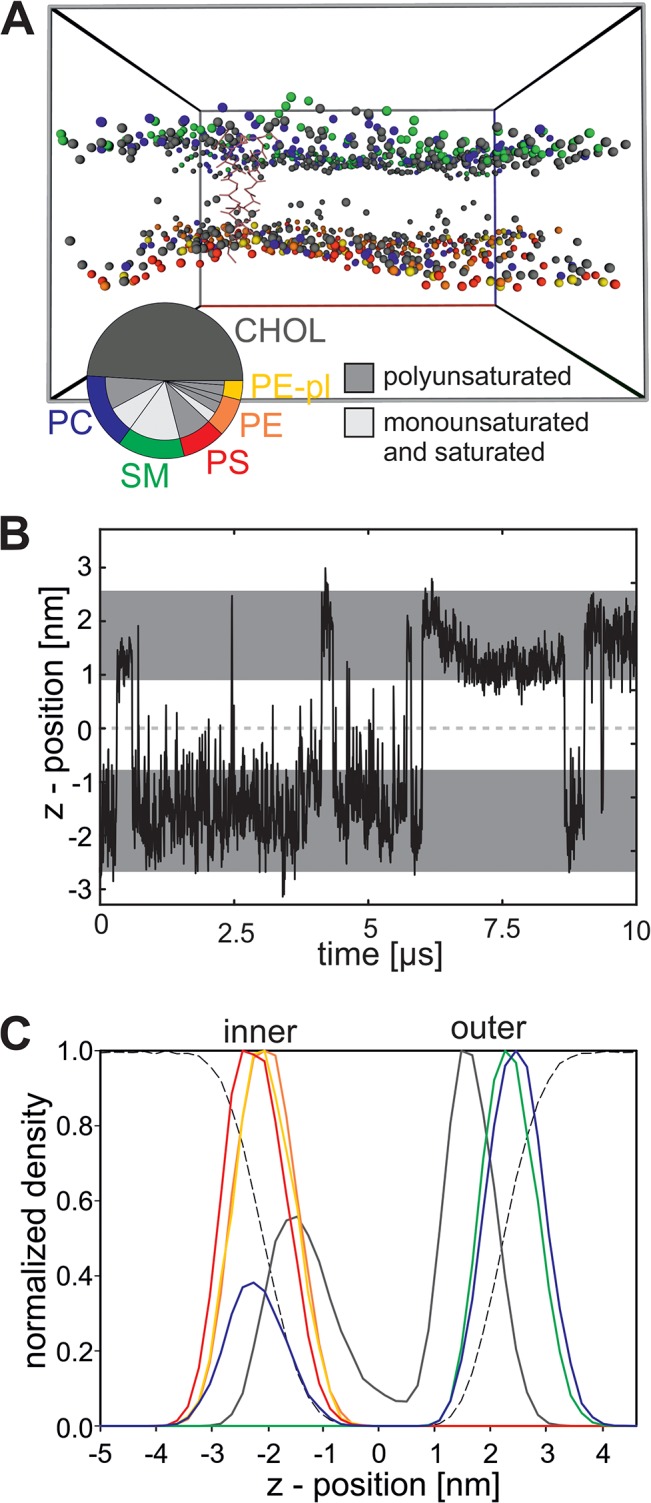
Model of the RBC plasma membrane.(A) The native membrane system in the simulation box after 10 μs simulation is shown. All water molecules are removed for clarity. The protein is shown in stick representation (rose). For lipids only one bead is displayed: For cholesterol (CHOL) the ROH bead (hydroxyl group(grey), for PC (blue), SM (green), PS (red), PE (orange) and PE-pl (yellow) one bead of the lipid linker (GL1 or AM1). The pie chart displays the composition of the native-like membrane. The outer ring corresponds to the head group and the inner ring to the fatty acid. Because cholesterol does not contain a classical fatty acid, only one ring is displayed. (B) Position of the ROH bead of a representative cholesterol molecule during the simulation of the native-like membrane. The dark grey areas indicate the position (average ± 2*standard derivation) of the lipid backbone (bead GL1 of PE 16:0/18:1 for the inner leaflet and bead AM1 of SM for the outer leaflet). (C) Density profile across the native-like membrane for one representative simulation. For all lipids the density of the outermost bead is shown (cholesterol: ROH; PC and SM: NC3; PS: CNO; PE and PE-pl: NH3). The color code is given in A.